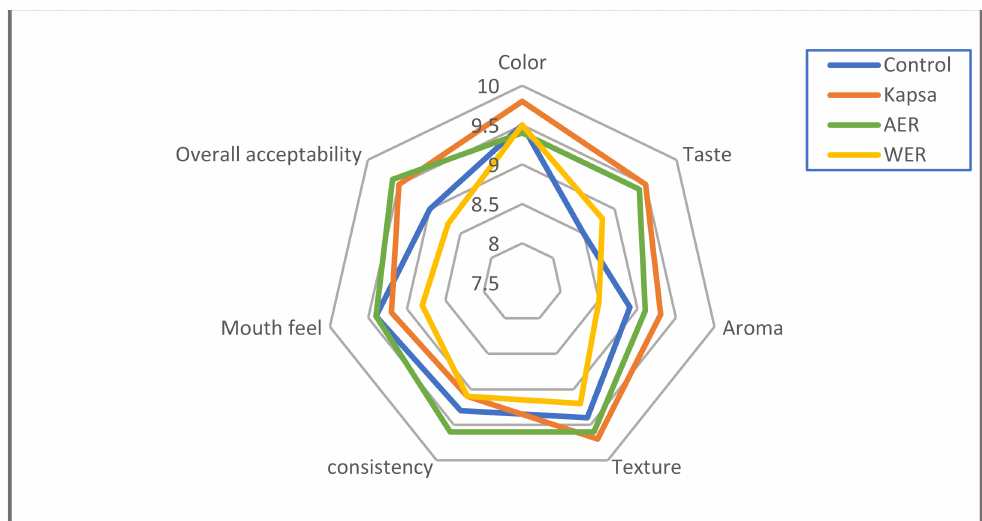
Figure 4. Sensory evaluation of various recipes of cooked rice samples. The control represents normal rice cooking recipe; Kapsa represents the traditional recipe of spice rice, AER: represents the rice treated by aromatic extract of the spice mixture; WER: represents the rice treated by water extract of the spice